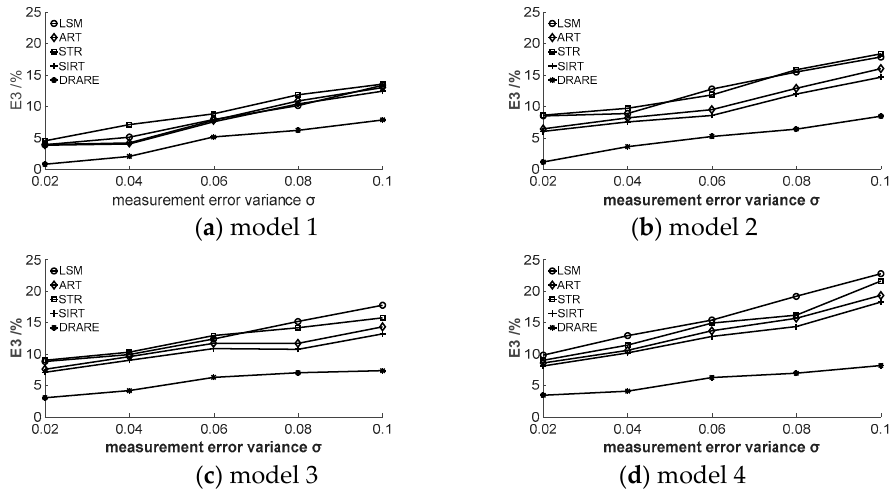
Figure 9. The influence of noise on the mean root square error.